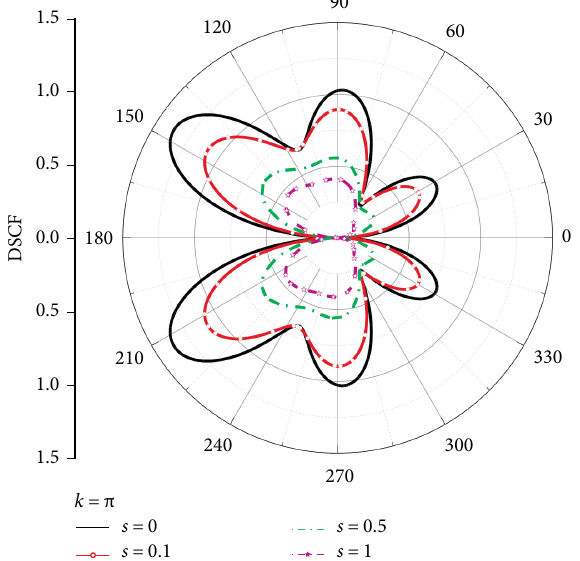
Figure 5: Distributions of DSCF around an elliptic hole with various 𝑠 for 𝑎 = 1 , 𝑏 = 0.6 , 𝐾 = 0.5 .